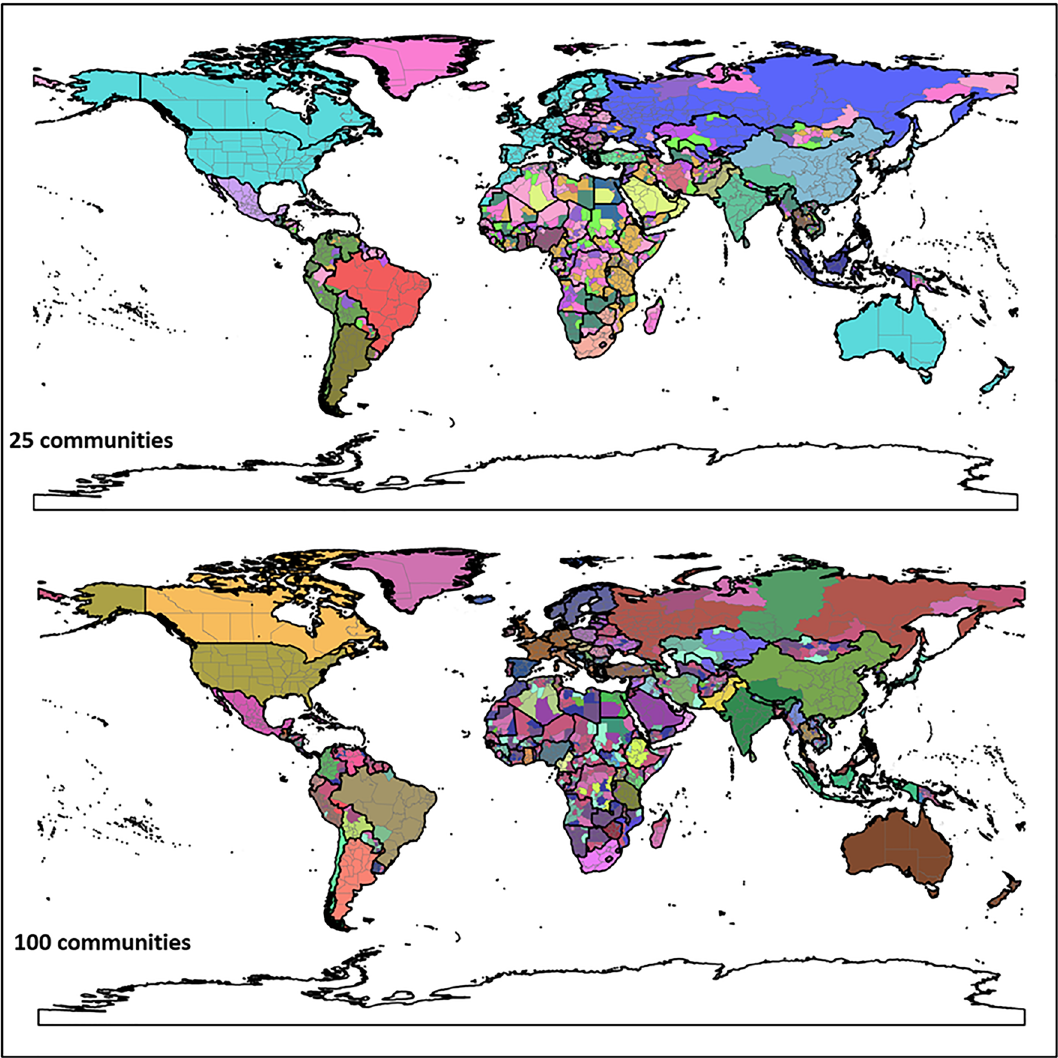
Figure 12. Results of the hierarchical agglomerative clustering of PCI with 25 and 100 targeted numbers of communities for the worldwide country first-level subdivisions. Each color depicts a community. Boundary data was retrieved from GADM 56 . The maps were generated using GeoPandas version 0.90.0 with Python (https:// geopa ndas.